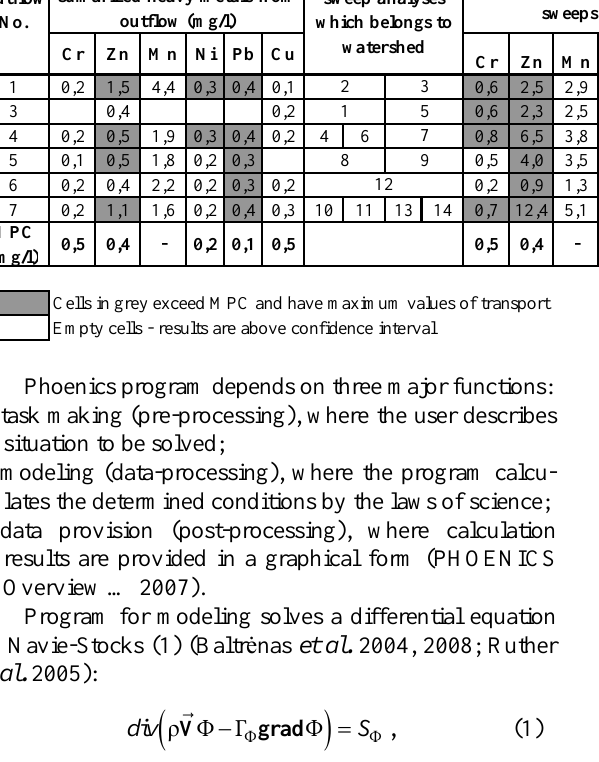
Table 2. Heavy metals concentration in outflow and pollution in each watershed (mg/l)Outflow outflow No.